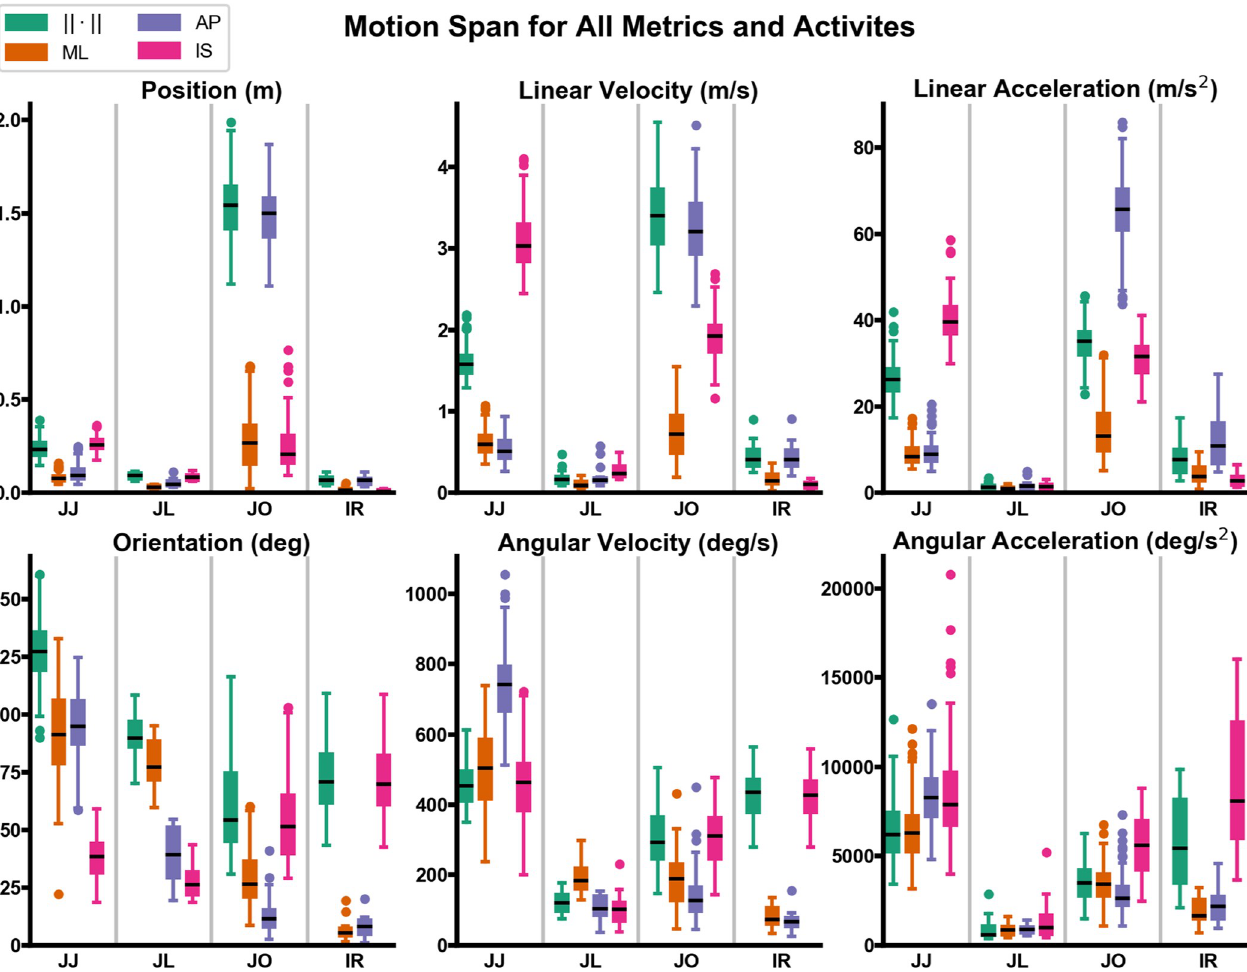
Fig 6. Boxplots of motion span for all activities and metrics. For jumping jacks (JJ), jug lifts (JL), jogging (JO), and internal rotation (IR) trials the span (max-min) of each kinematic variable in the mediolateral (ML), anterior-posterior (AP), and inferior-superior (IS) direction of the thorax is presented. The span of the magnitude of each kinematic variable is also presented as the Euclidean norm ( k�k